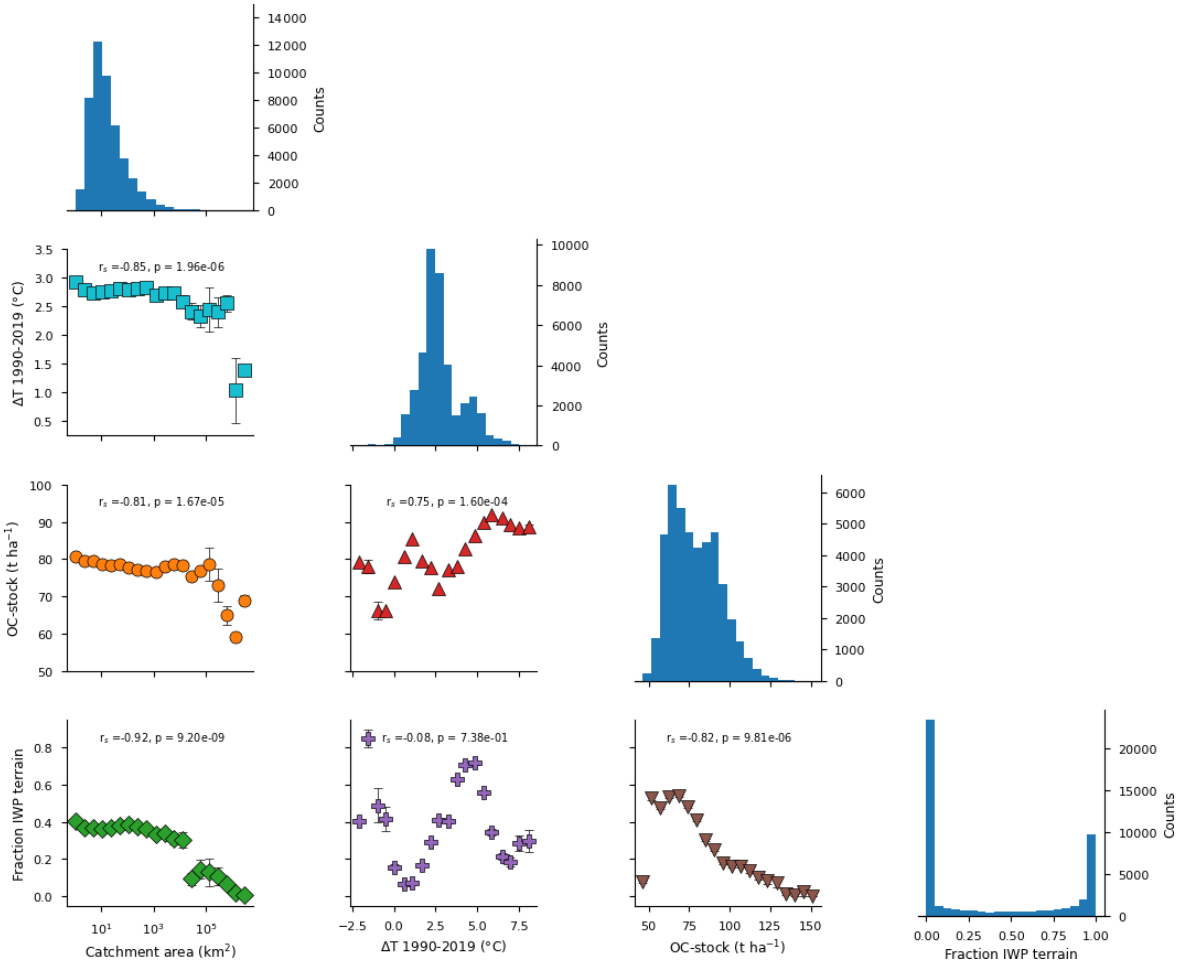
Figure 4. Correlations of binned data of selected catchment properties from our database. We calculated Spearman’s rho on the binned data. Most notably, we observe that small watersheds have experienced the greatest warming while having the highest mean carbon stocks and the highest fraction of IWP terrain. Similarly, the data show that high OC stocks are found where most warming has